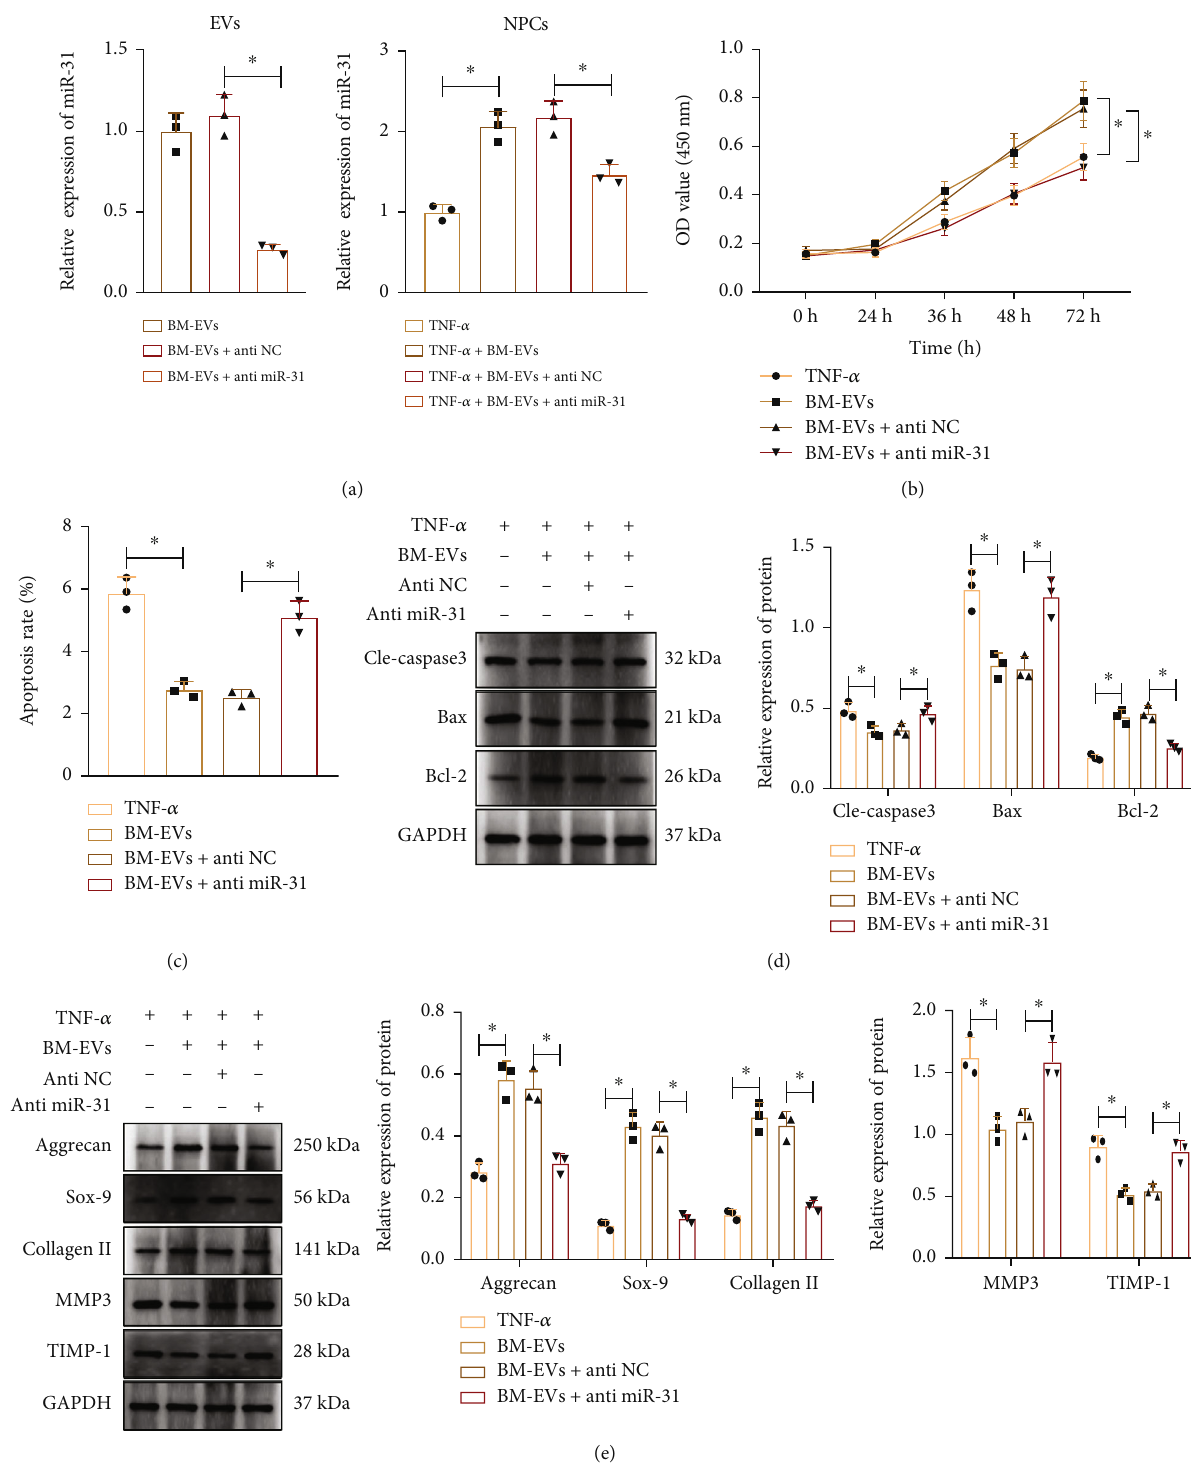
Figure 5: miR-31 in hBMSC-EVs augments NPC proliferation and inhibits cell apoptosis and ECM degradation in NPCs. (a) miR-31 expression in EVs from hBMSCs transduced with lentivirus carrying anti-miR-31 (left) and in TNF- α -treated NPCs cocultured with BMSCs-EVs+anti-miR-31 (right) determined by RT-qPCR. (b) Proliferation of TNF- α -treated NPCs cocultured with BMSCs-EVs+anti- miR-31 determined by CCK-8 assay. (c) Apoptosis of TNF- α -treated NPCs cocultured with BMSCs-EVs+anti-miR-31 determined by fl ow cytometry. (d) Protein expression of apoptosis-related genes cleaved caspase-3, Bax, and Bcl-2 in TNF- α -treated NPCs cocultured with BMSCs-EVs+anti-miR-31 determined by Western blot. (e) Protein expression of ECM-related genes in TNF- α -treated NPCs cocultured with BMSCs-EVs+anti-miR-31 determined by Western blot. ∗ p < 0 : 05 . Cell experiments were repeated three